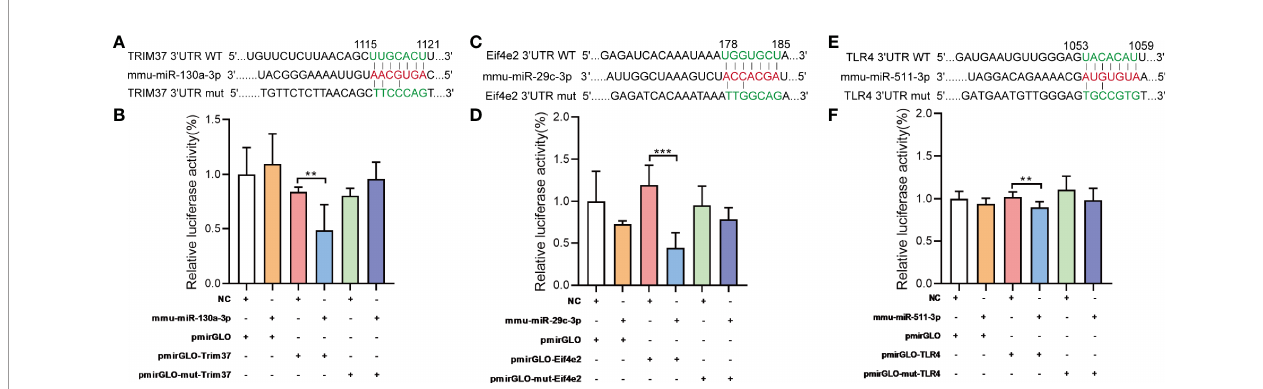
FIGURE 7 | Target validations of differential miRNAs. (A) The series of miR-130a-3p combined with TRIM37; nucleotides in the seed region of pmirGLOTRIM37 and pmirGLOTRIM37-mut constructs are highlighted in red. (B) Luciferase reporter assays were carried out in HEK293 cells, using renilla luciferase as the endogenous control. Data were presented as mean ± SD and were generated from three independent experiments. (C) The series of miR-29c-3p combined with Eif4e2; nucleotides in the seed region of pmirGLOEif4e2 and pmirGLOEif4e2-mut constructs are highlighted in red. (E) The series of miR-511-3p combined with TLR4; nucleotides in the seed region of pmirGLOTLR4 and pmirGLOTLR4-mut constructs are highlighted in red. (B, D, F) Luciferase reporter assays were carried out in HEK293 cells, using renilla luciferase as the endogenous control. Data were presented as mean ± SD and were generated from three independent experiments (**p < 0.01, ***p <